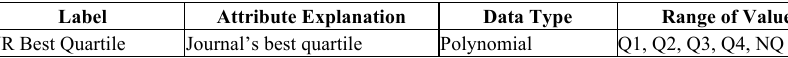
Table 2. Detail of label class attribute